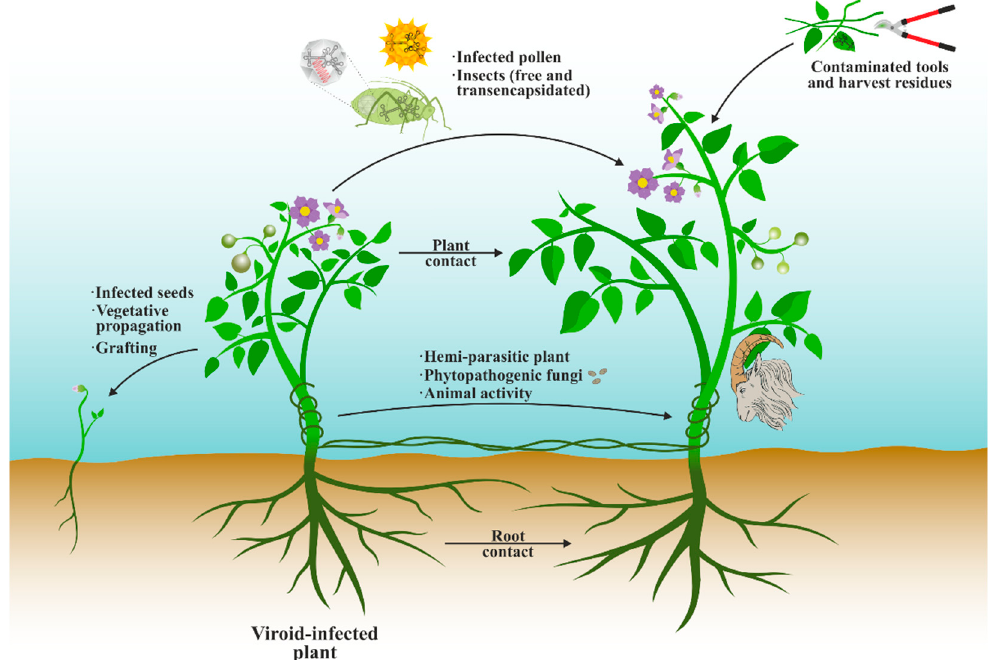
Figure 5. Some mechanisms of viroid transmission between plants.